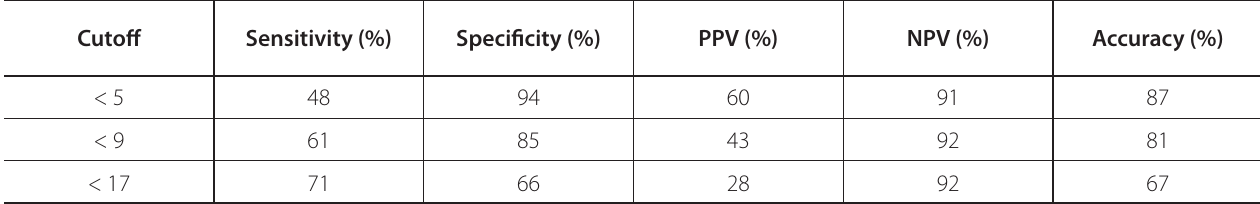
Table 5 . Comparison of diagnostic values of different cutoff points for the lowest central venous oxygen saturation (ScvO arterial lactate ratio for prediction of major adverse